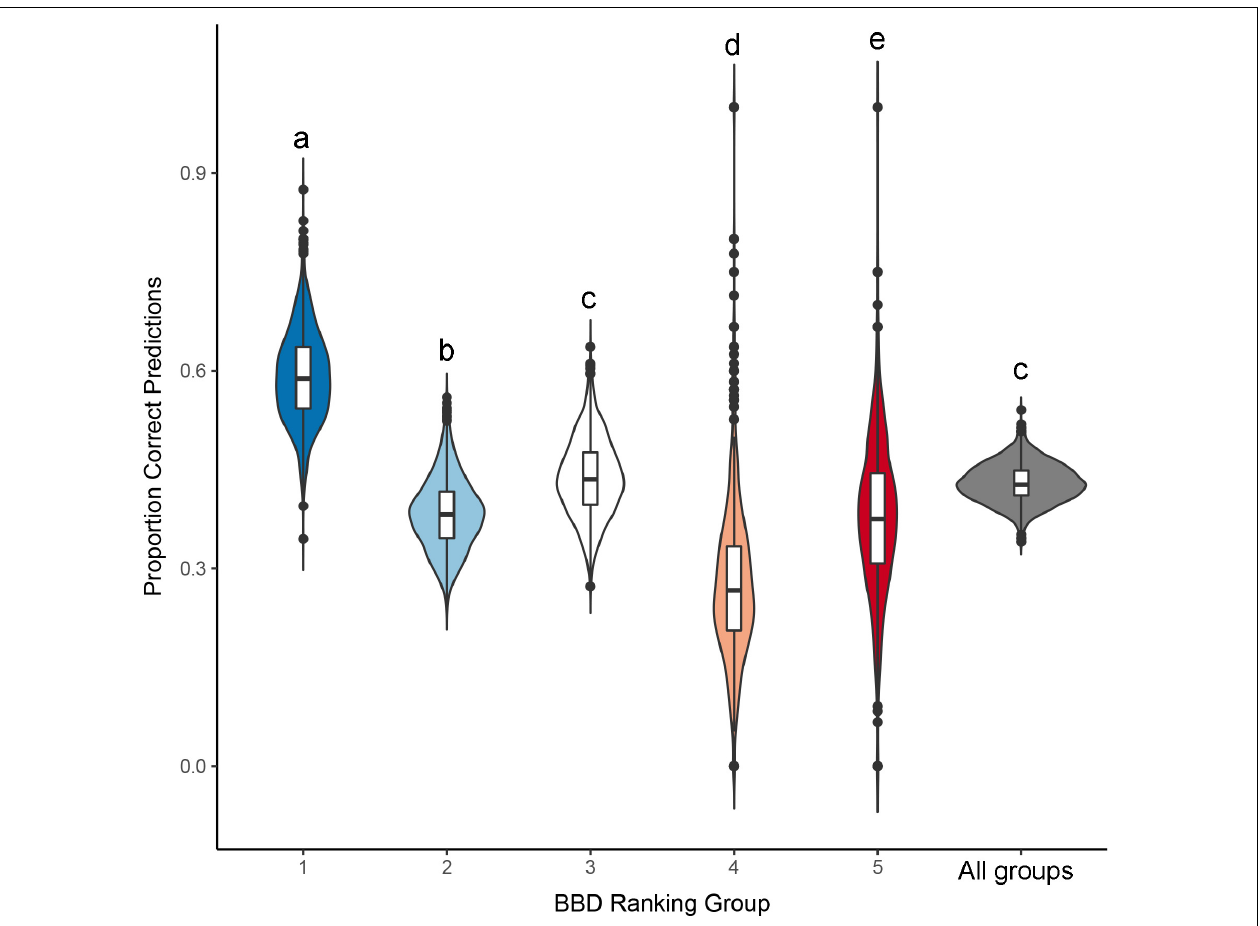
FIGURE 3 | Proportion of correct predictions derived from an ordinal logistic regression model, predicting beech bark disease (BBD) severity as a function of tree diameter and relative growth rate. Distributions presented here were derived from a randomization procedure, that predicted BBD severity based on a model fit to a training dataset ( n = 491 randomly selected points) which was then used to predict BBD severity in a validation data (the remaining n = 160 points). Central horizontal line in each violin represents the median prediction accuracy within individual BBD severity groups, or across all groups considered together, and the length of the vertical lines represent the interquartile range of these distributions. Different letters above each distribution denote statistically significant differences ( p < 0.05), as per a Tukey’s HSD post-hoc